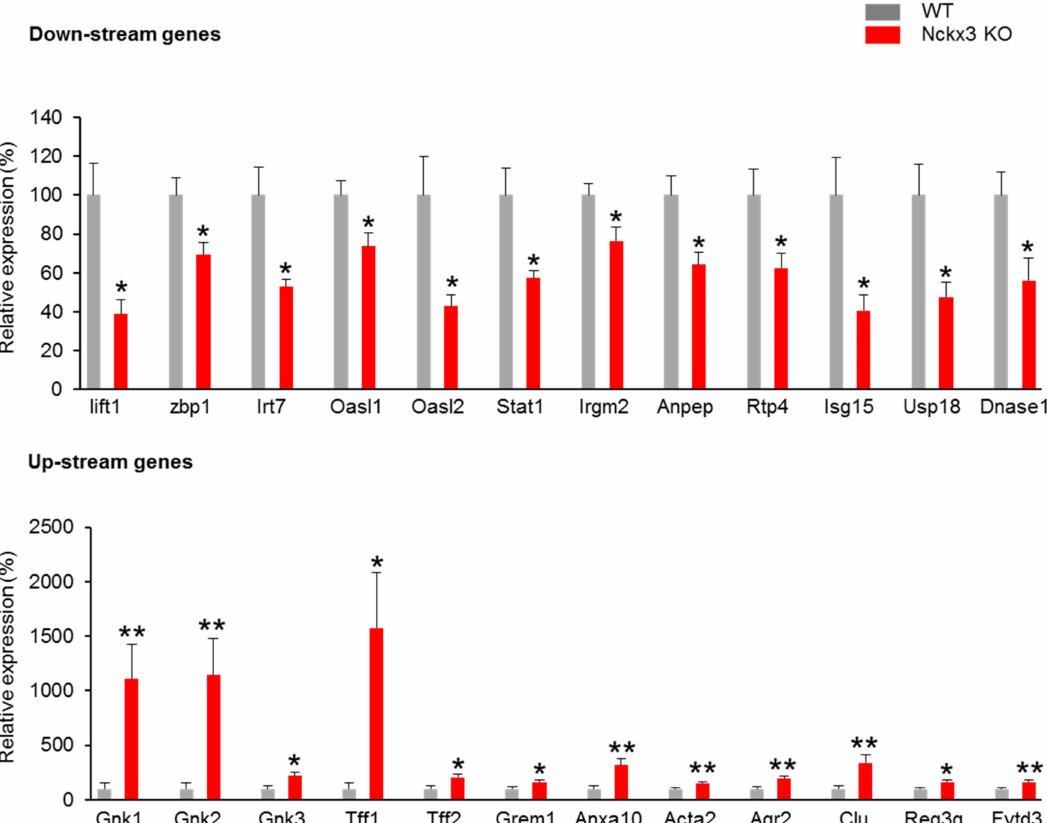
Figure 2. mRNA levels of the top twelve most up and downstream genes were assessed in WT and Nckx3 KO duodenum tissues using real-time PCR (n = 10 per genotype). Data represent the mean ± SEM. Statistical significance was determined by two-way ANOVA, * p < 0.05 WT vs. Nckx3 KO, ** p < 0.01 WT vs. Nckx3